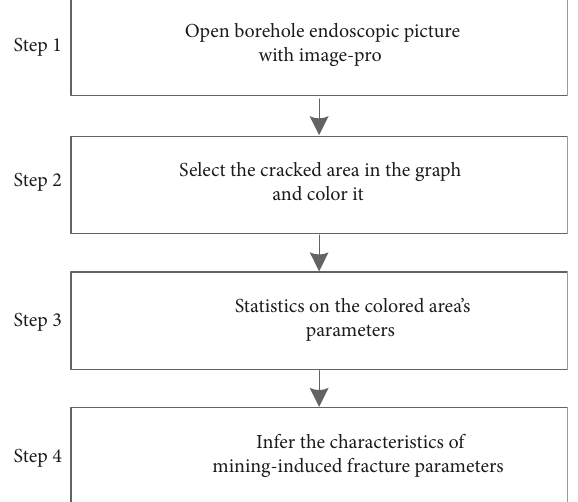
Figure 10: The analysis process of borehole endoscopic images using Image-Pro